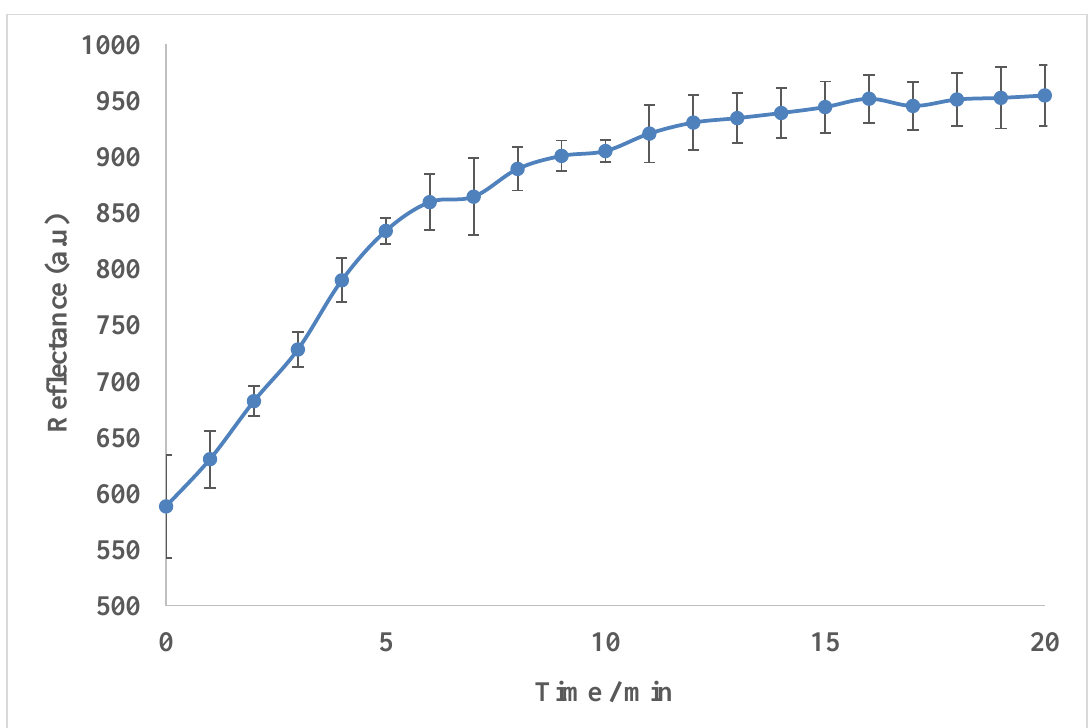
Figure 10. Response time of the biosensor towards 500 mM urea in 50 mM phosphate buffer at pH 7 ( n =